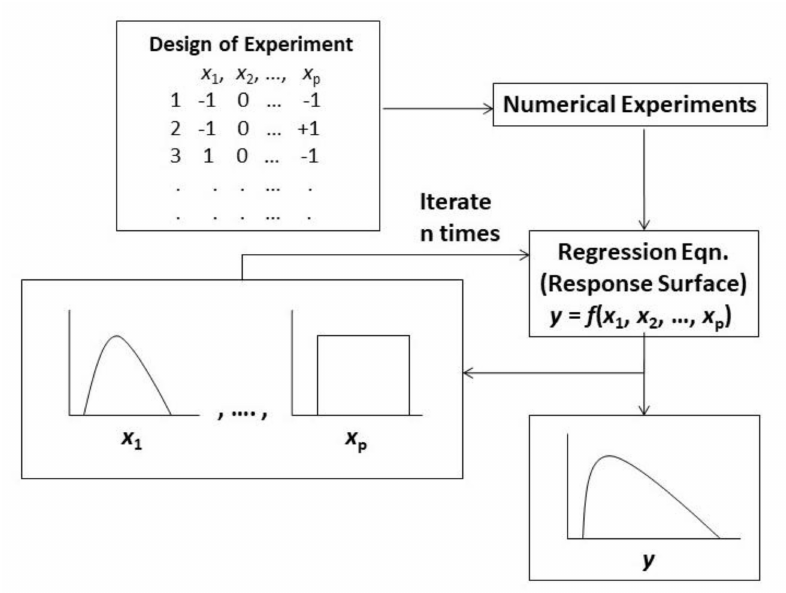
Figure 4. Workflow for the response surface methodology combined with Monte Carlo simulation. For example, reservoir permeability, anisotropy ratio of permeability (kv/kh), water-alternating-gas (WAG) time ratio are x 1 , x 2 , x 3 , and x 4 . In addition, net CO 2 storage and oil production are y 1 and y 2 in Pan et al.